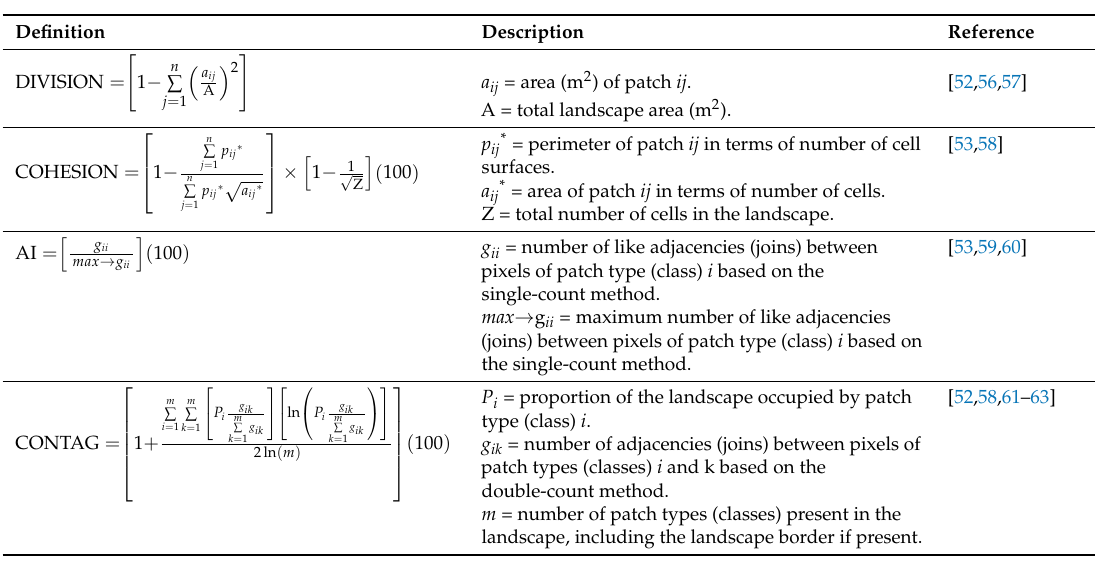
Table 2. Landscape metrics used in this